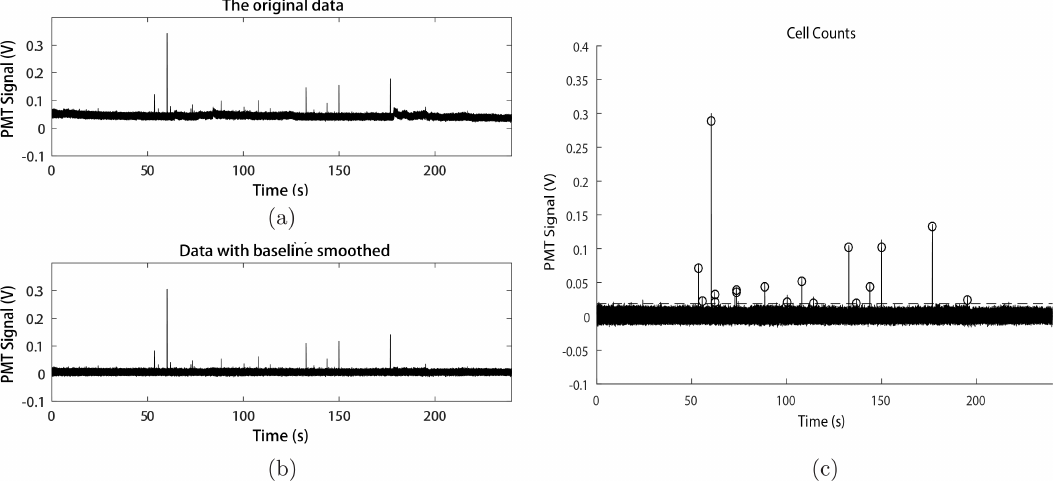
Fig. 5. A signal with gentle baseline °uctuation is processed after correcting baseline drift. (a) The baseline level of the original signal °uctuated irregularly. (b) The baseline of the signal is less °uctuated after correcting the drift. (c) Cell peaks after correcting baseline drift shows the counting result of cells (Table